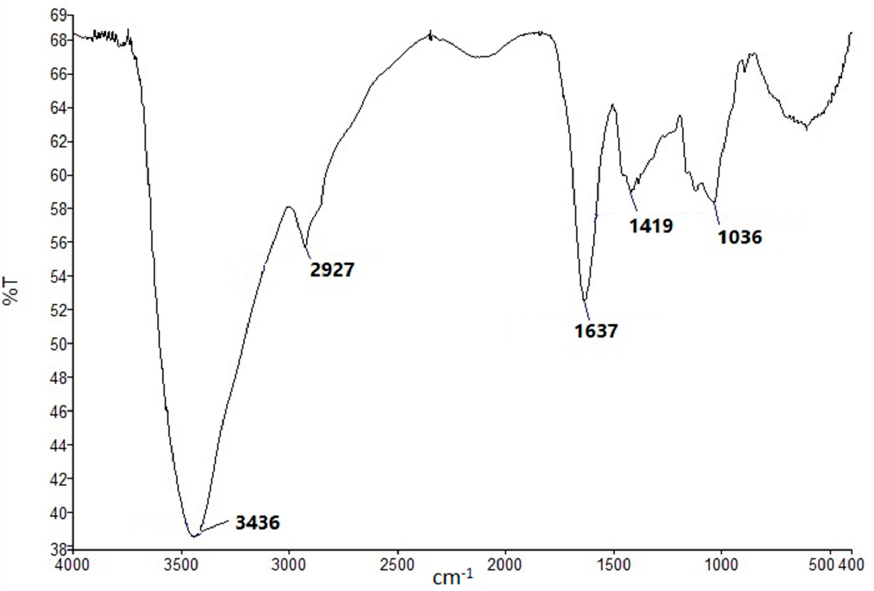
Figure 2. FT-IR spectra of fraction SJZDP-II-I.